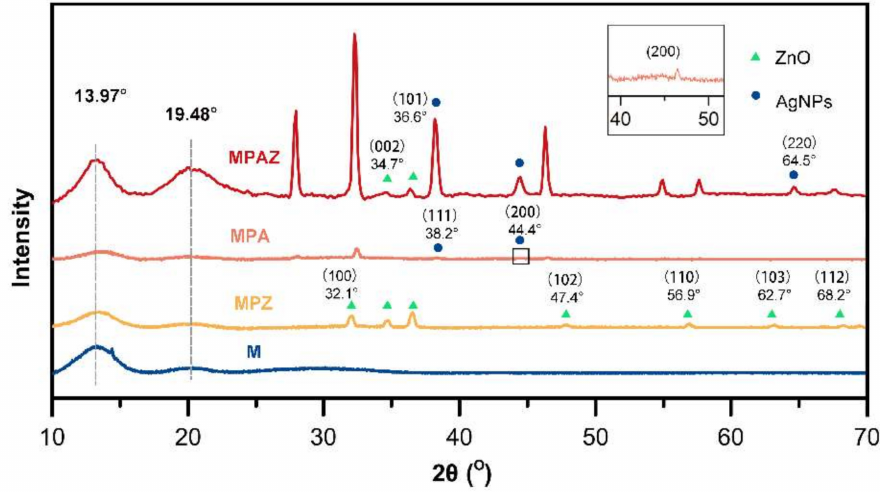
Figure 3. The characteristic XRD patterns of the